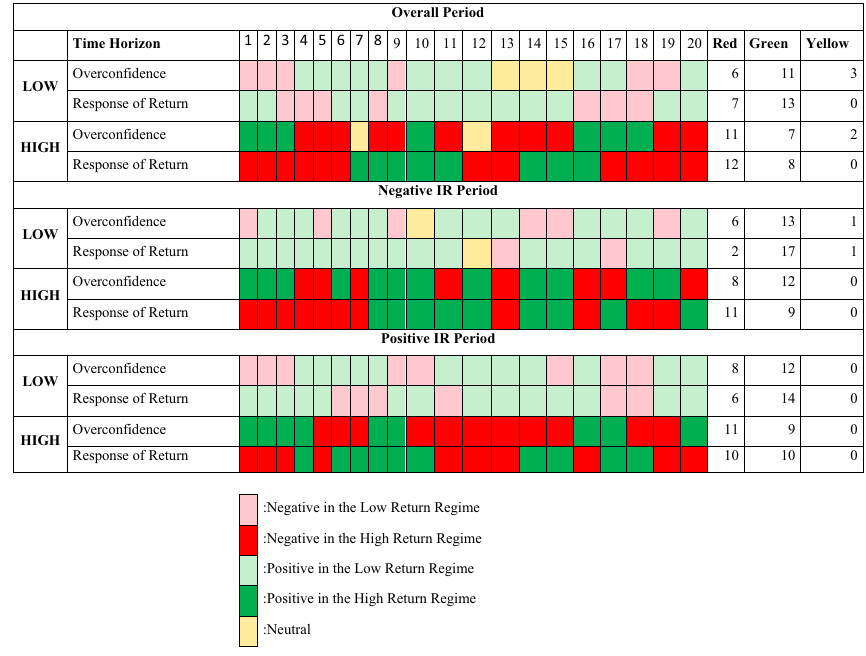
Fig. 6 The change in overconfidence and in the response of returns. Note : Positive means the existence of overconfidence while negative means that overconfidence doesn’t exist. For “response of return”, positive means that the line is above zero or negative if the line is below zero